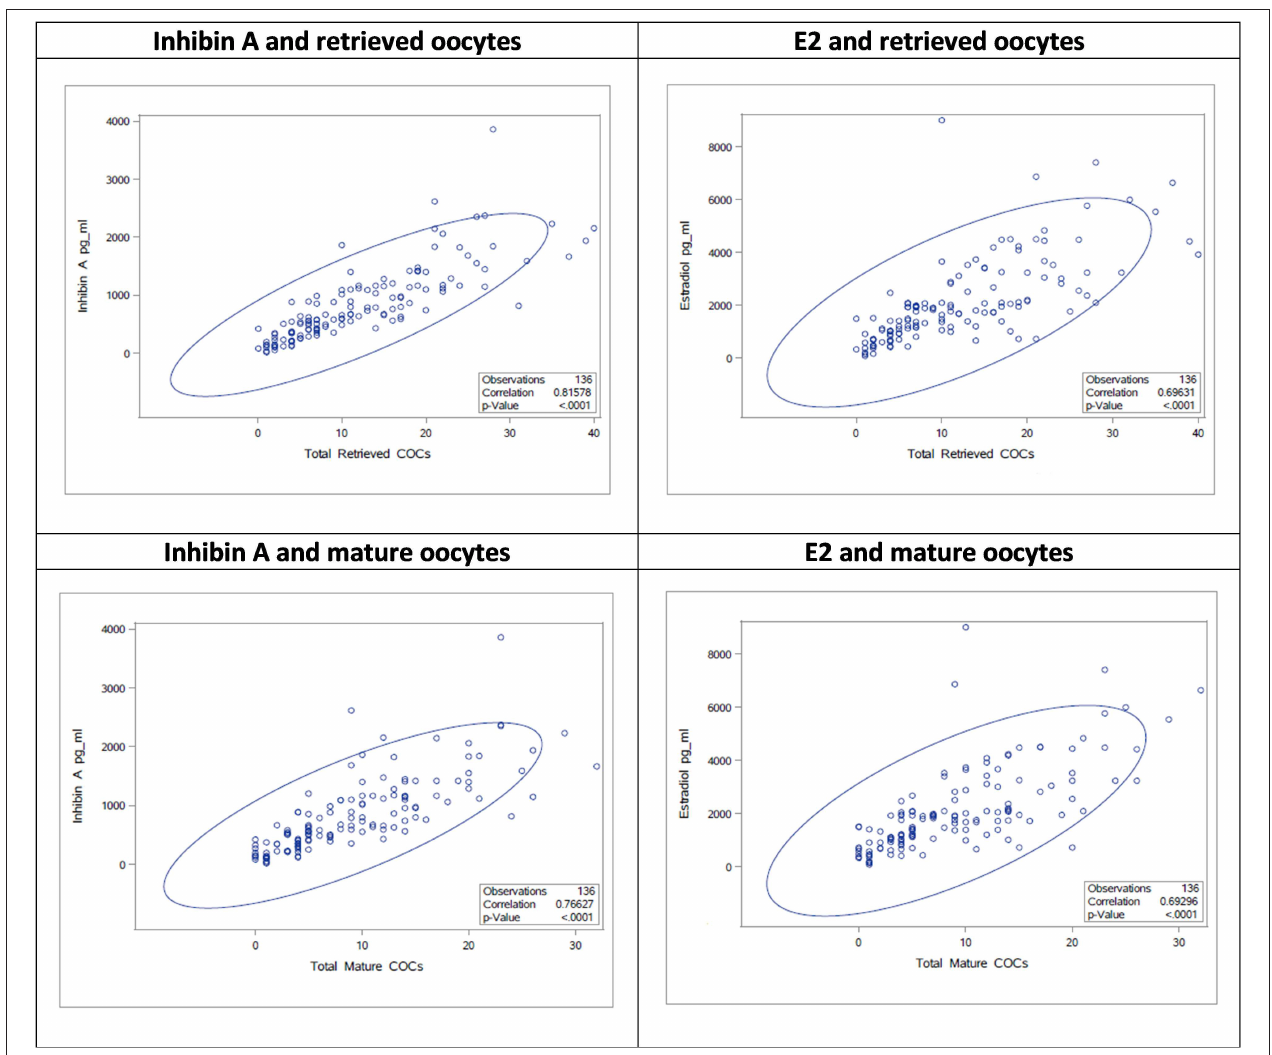
FIGURE 1 | ROC curve analysis of Inhibin A and E2 according to the number of ≥ 10 mature